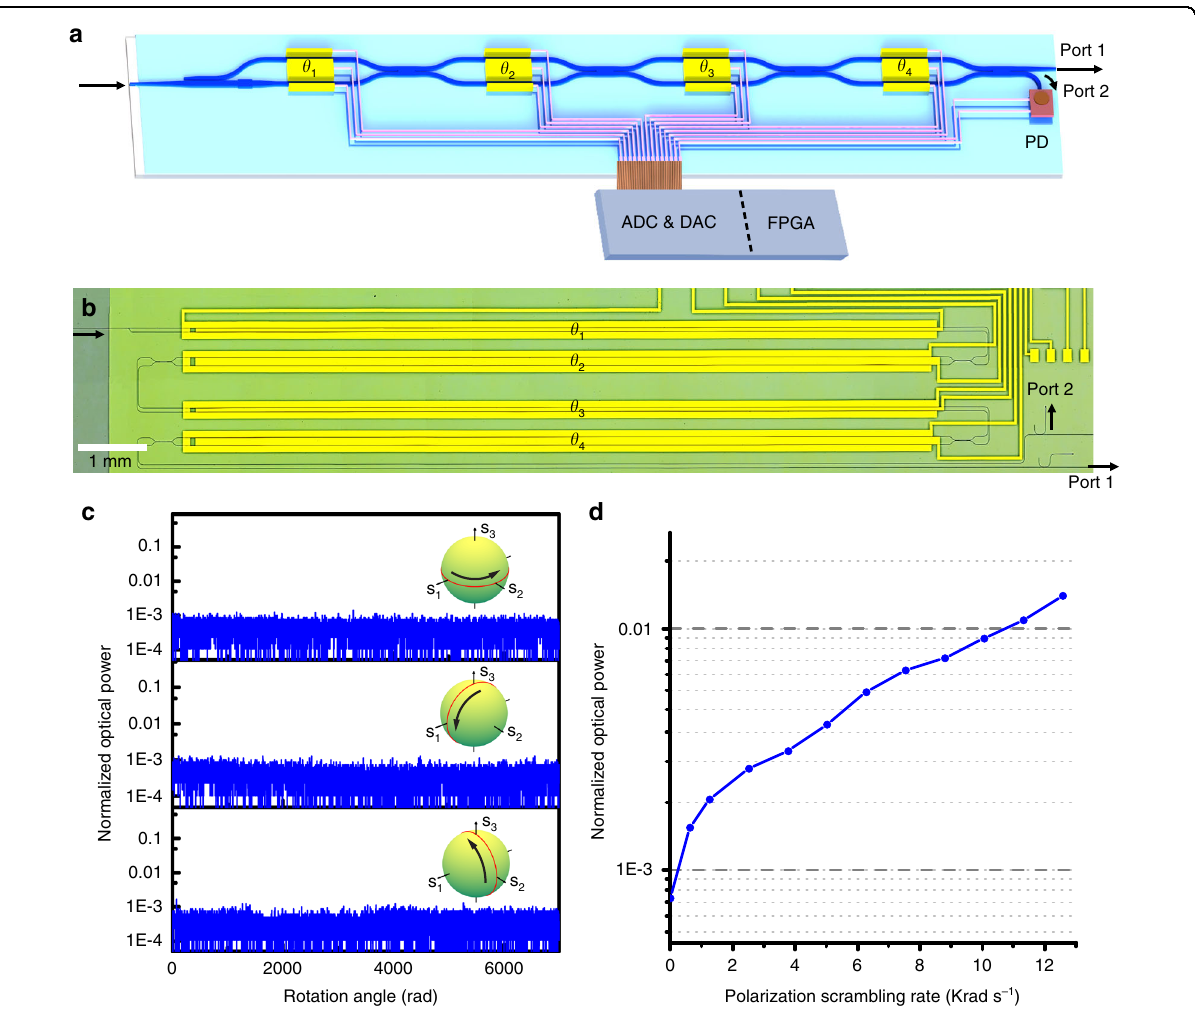
Fig. 5 The performance of the endless automatic polarization controlling device. a The schematics of the proposed endless automatic polarization controlling device. DAC digital-to-analog converter, ADC analog-to-digital converter, FPGA fi eld-programmable gate array, PD fl ip-chip bonded photodetector. b The microscope image of the fabricated device. θ 1 , θ 2 , θ 3 and θ 4 in a and b mark the phase shifters. c The normalized optical power of the PD as a function of the rotation angle of the input polarization. Insets: the rotation trajectories of the input polarization states for demonstrating the capability of the endless operation. d The normalized optical power of the feedback signal as a function of the polarization scrambling